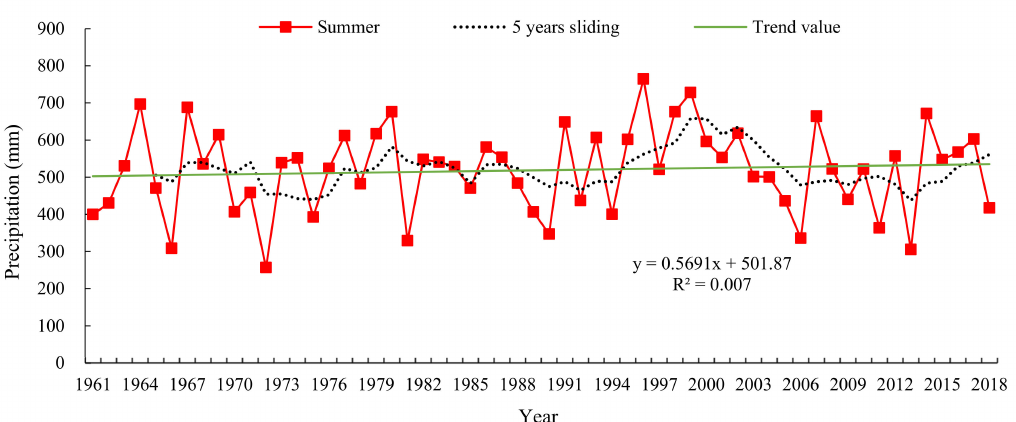
Figure 3. Seasonal precipitation in the Wujiang River Basin